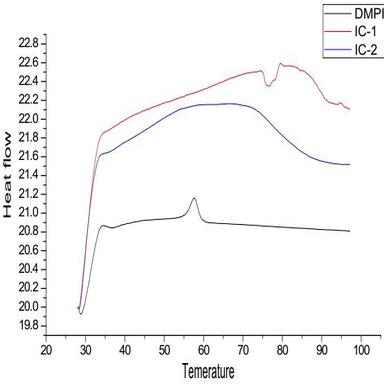
DSC thermograms of solid DMPI and their ICs (IC-2 & IC-1 i.e. Complexes of β -CyD and HP-β-CyD respectively).